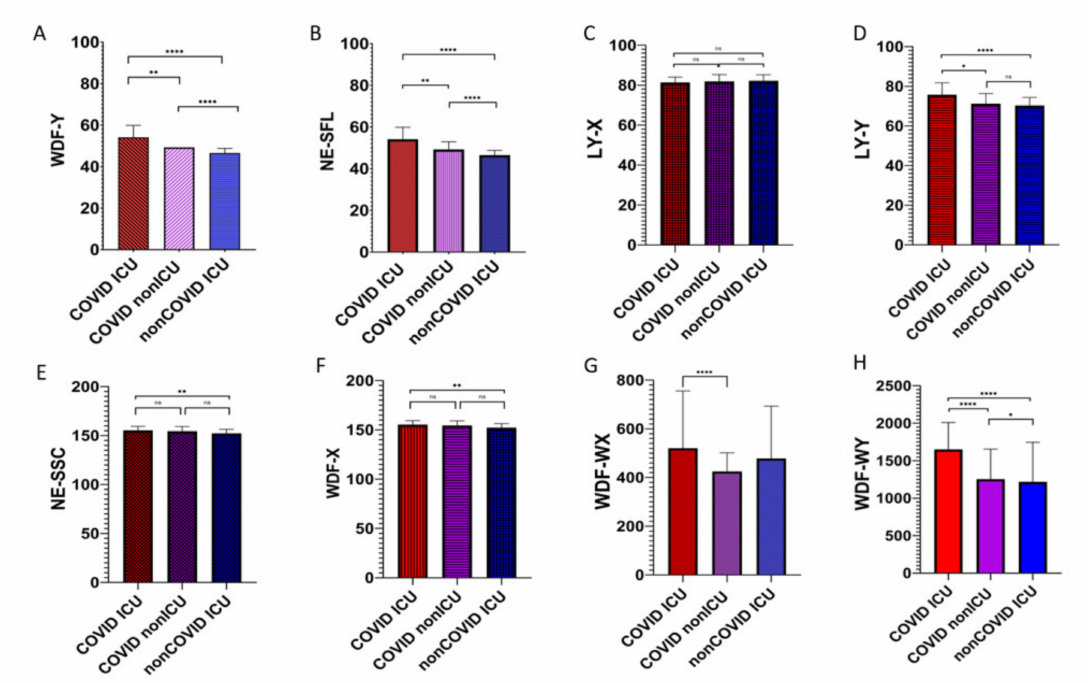
Figure 3. Cell population data (CPD) analysis of graphical results (WDF scattergram) including leukocyte differentiation in three groups: COVID ICU, COVID non-ICU, and non-COVID ICU. A -WDF-Y leucocyte fluorescence (leucocyte size), B - NE-SFL, the fluorescent light intensity of the NEUT area on the WDF scattergram (neutrophils size), C- LY-X, the lateral scattered light intensity of the LYMPH area on the WDF scattergram (lymphocyte granularity and the amount of genetic material), D - LY-Y, the fluorescent light intensity of the LYMPH area on the WDF scattergram (lymphocyte size), E - NE-SSC, the lateral scattered light intensity of the NEUT area on the WDF scattergram (neutrophils granularity and the amount of genetic material), F - WDF-X leucocyte complexity (leucocyte granularity and amount of genetic material), G - WDF-WX width of dispersion of leucocyte (leucocytes granularity and the amount of genetic material), H - WDF-WY width of dispersion of leucocyte fluorescence (leucocytes size); ( n = 735, * p < 0.05, ** p < 0.01, **** p <